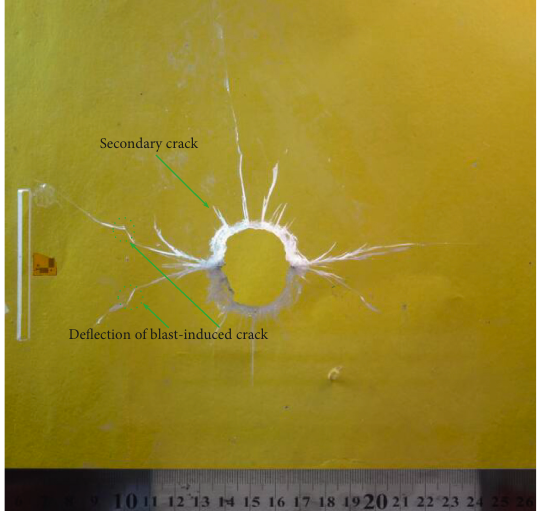
Figure 26: Blasting effect drawing for case SN I -4.